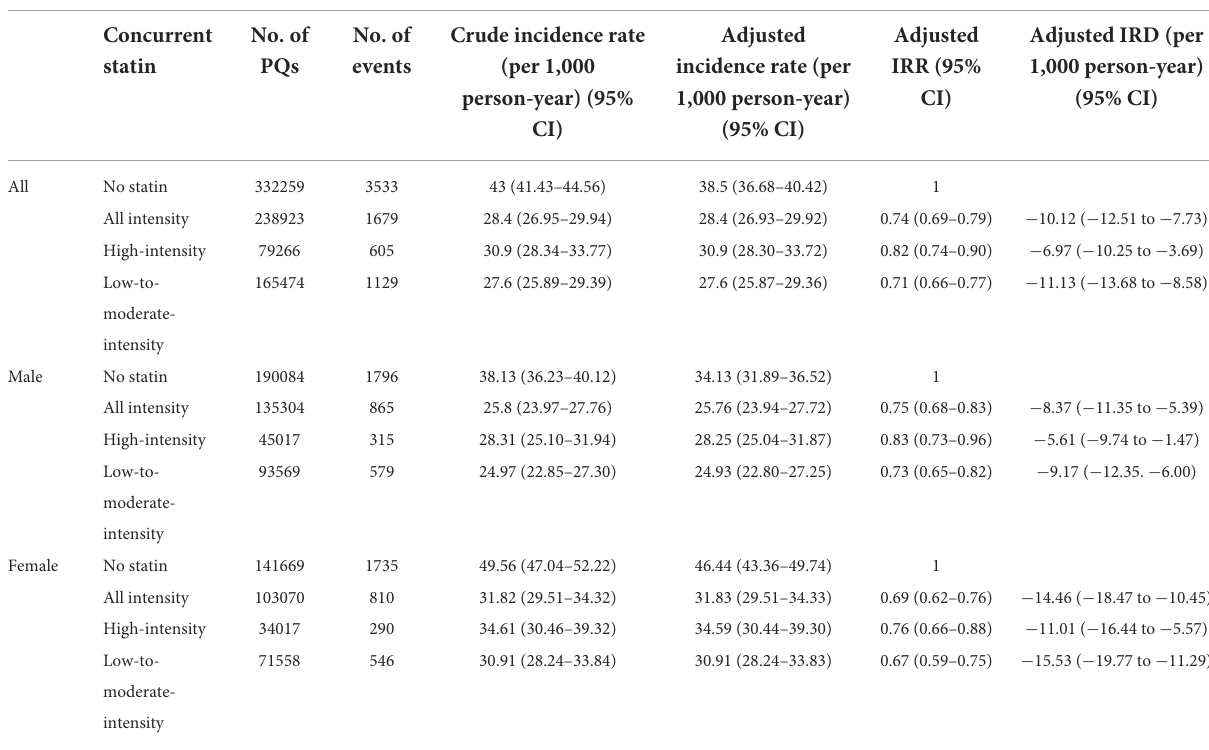
TABLE 4 Gastrointestinal tract bleeding among DOAC using